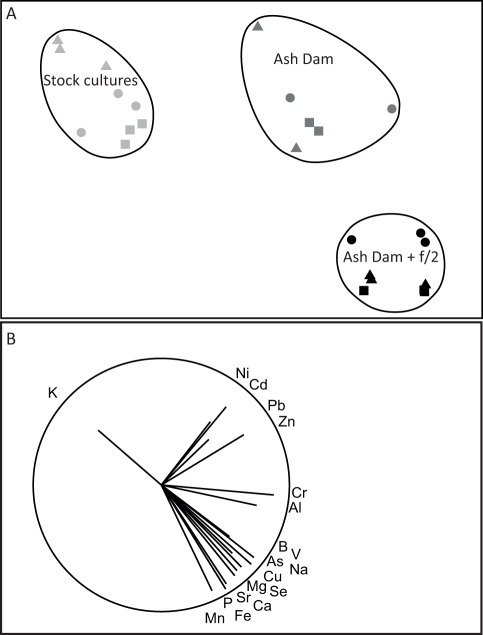
Non metric multidimensional scaling plot showing the similarity between algal species and treatments based on elemental composition.(A) nMDS plot (Stress  = 0.05) with the groups from the cluster analysis superimposed. Triangles represent Rhizoclonium, circles represent Oedongonium and squares represent Hydrodictyon. (B) The same nMDS as A, with vectors superimposed, the length and direction of which indicates the strength of the correlation and direction of change between the two nMDS axes. Only elements with a correlation coefficient of 0.5 or greater are shown.